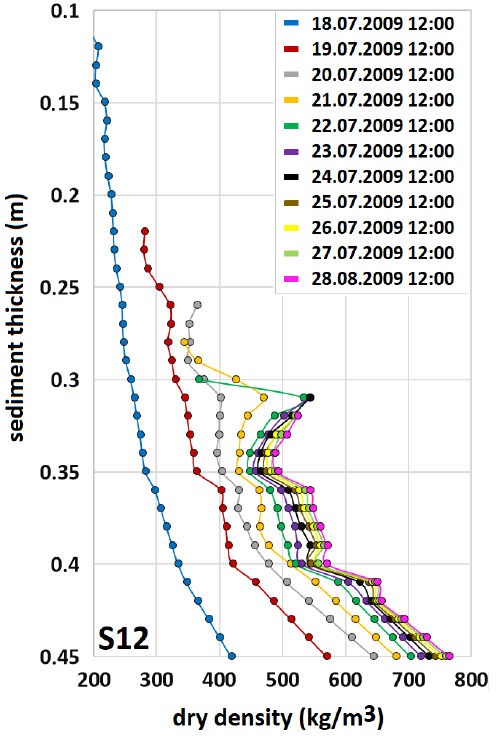
Figure 7. Dry density profile evolution as a function of the sediment depth at S12: model